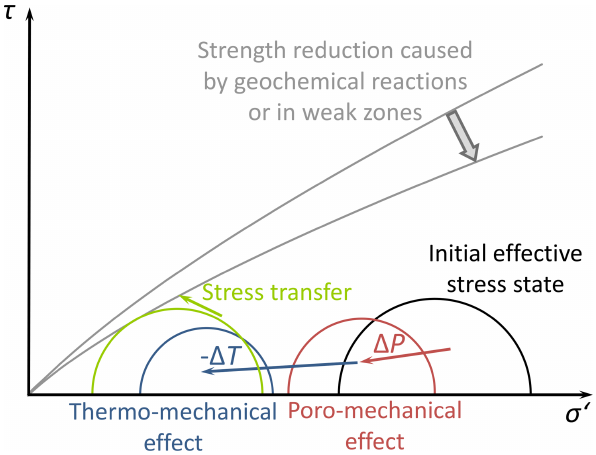
Figure 2. Schematic representation of several coupled effects on fracture and/or fault stability. Pressure buildup, (cid:49)P , decreases the effective stresses and may cause poro-mechanical stresses that change the size of the Mohr circle; cooling, − (cid:49)T , induces thermal stress reduction; seismic and aseismic shear slip and interactions be- tween geological layers with different rock properties produce total stress changes; and geochemical reactions may alter the strength of fractures and/or